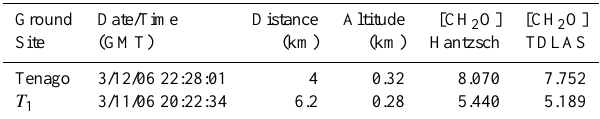
Table A1. DC-8 (TDLAS) and ground-based (Hantzsch) compar- isons of ambient CH 2 O over Mexico City. The distance is the air- craft distance to the site and the altitude is the height above ground from the aircraft radar. The mixing ratios are in ppbv.